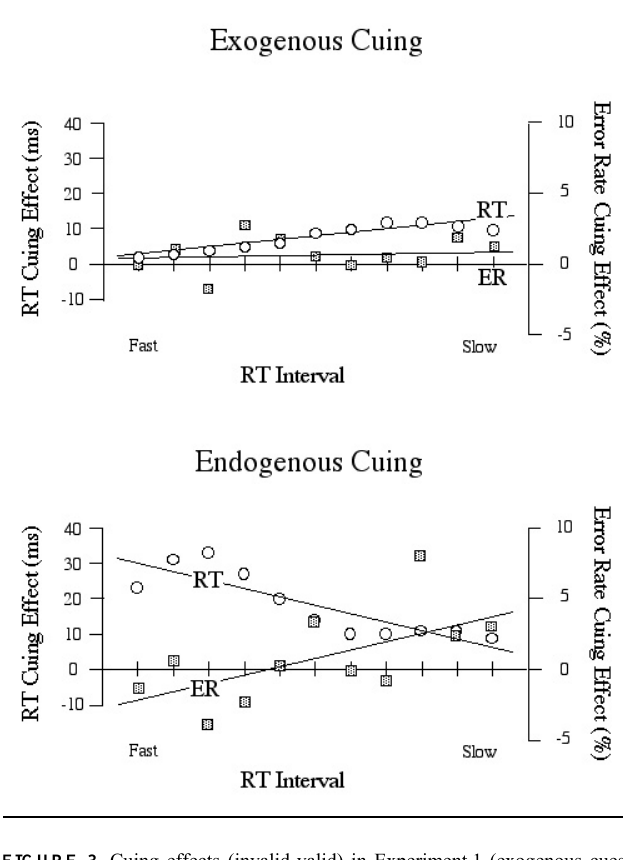
FIGURE 3 . Cuing effects (invalid-valid) in Experiment 1 (exogenous cues) and Experiment 2 (endogenous cues) across RT intervals. Open circles represent RTs, shaded squares represent